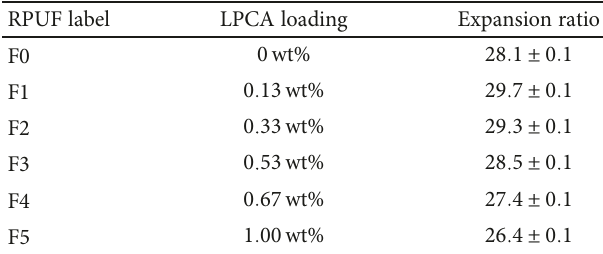
Table 3: E ff ect of LPCAs on the expansion ratio and the compressive strength of RPUFs.